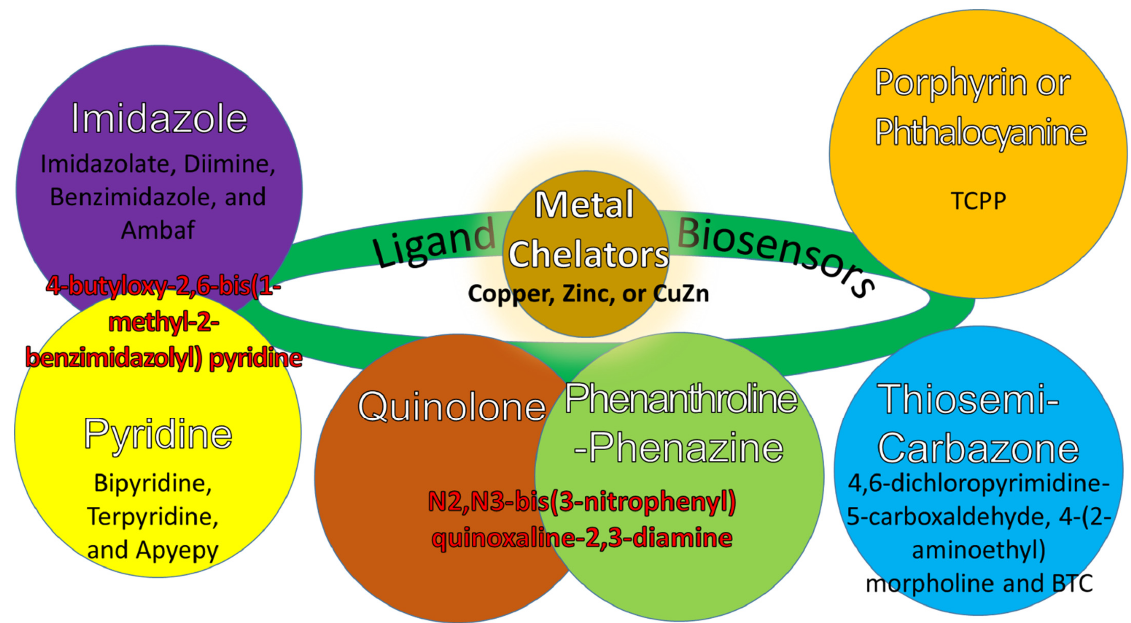
Figure 2. Ligand biosensors link organic solvent groups and metal chelators, resulting in their derivatives and combined derivatives